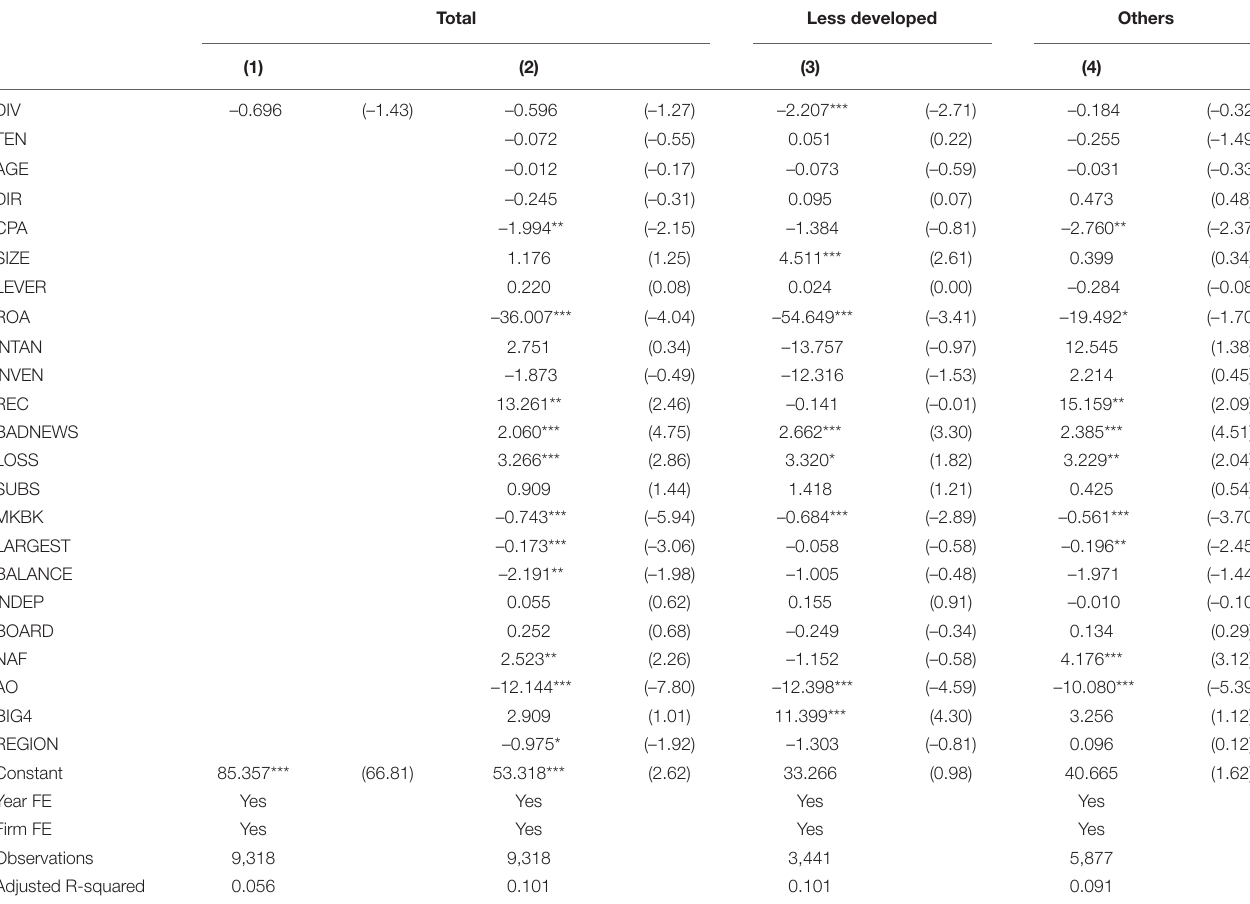
TABLE 5 | CFO functional diversity and timeliness for PEs